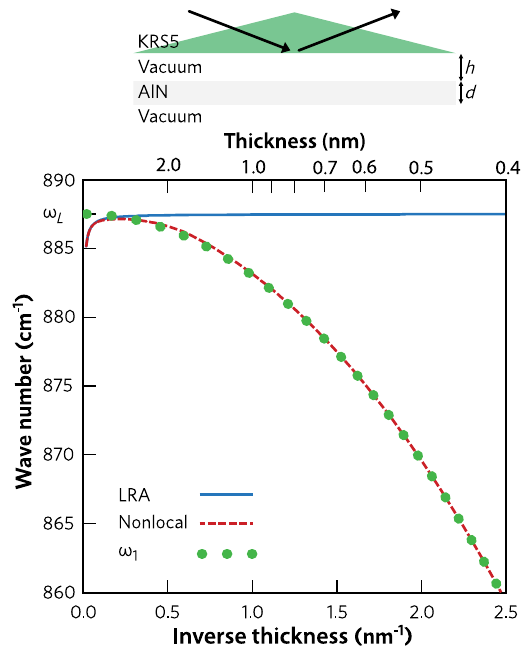
FIG. 4. Comparison of the local (blue solid line) and nonlocal (red dashed line) ENZ mode frequencies in an AlN film as a function of inverse film thickness d − 1 . The zone-center longi- tudinal optical phonon frequency ω is labeled on the axis and the L n ¼ 1 longitudinal mode energy from Eq. (11) by green circles. Above the plot a sketch of the Otto configuration considered is